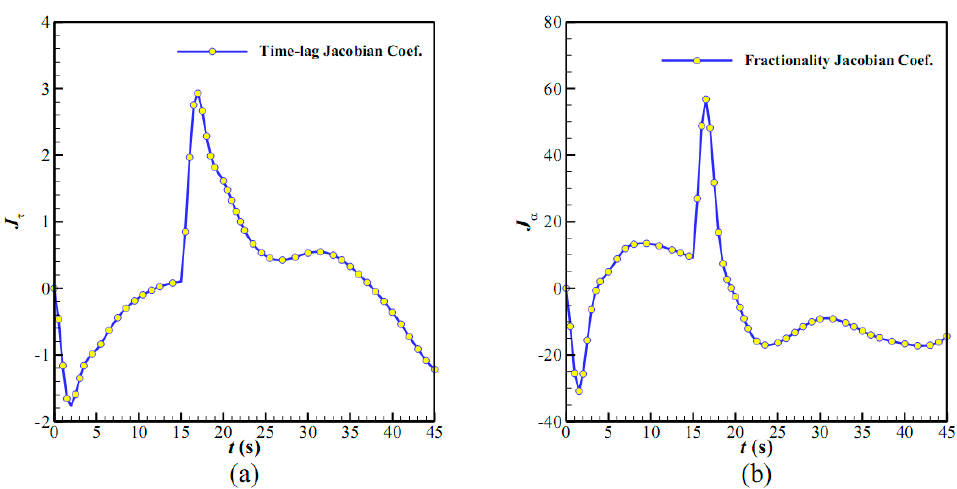
Figure 5. Comparison of the estimation temperature history from the FSPL model with the measured temperature from the DPL model for test case 2 ( a ) at the ED interface and ( b ) at the DF interface in skin tissue.